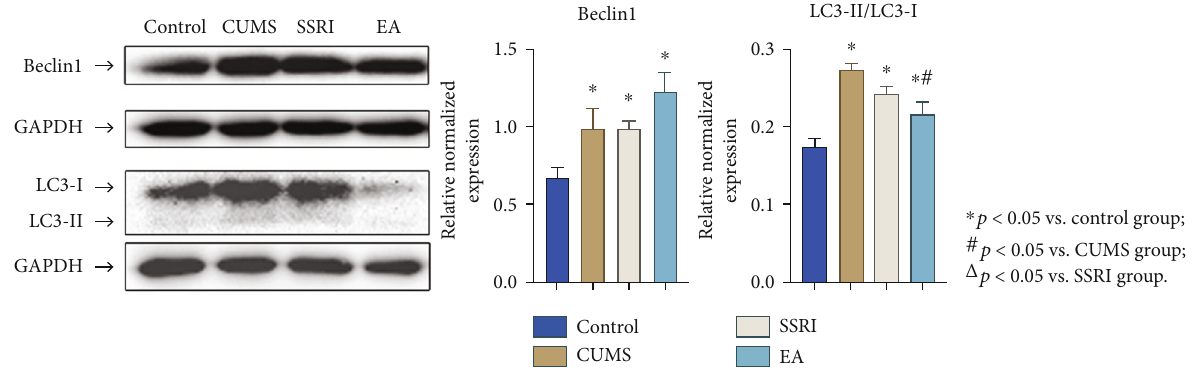
Figure 4: Expression of Beclin1 and LC3-II/LC3-I in hippocampus CA1 of each group (relative normalized; mean ± SEM ; n = 4